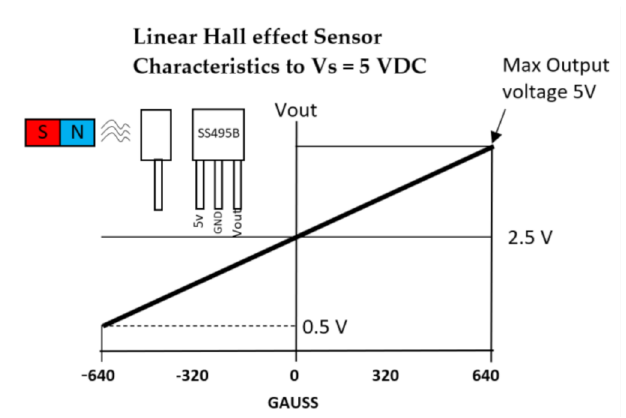
Figure 12. Hall effect characteristics at max 5 V.